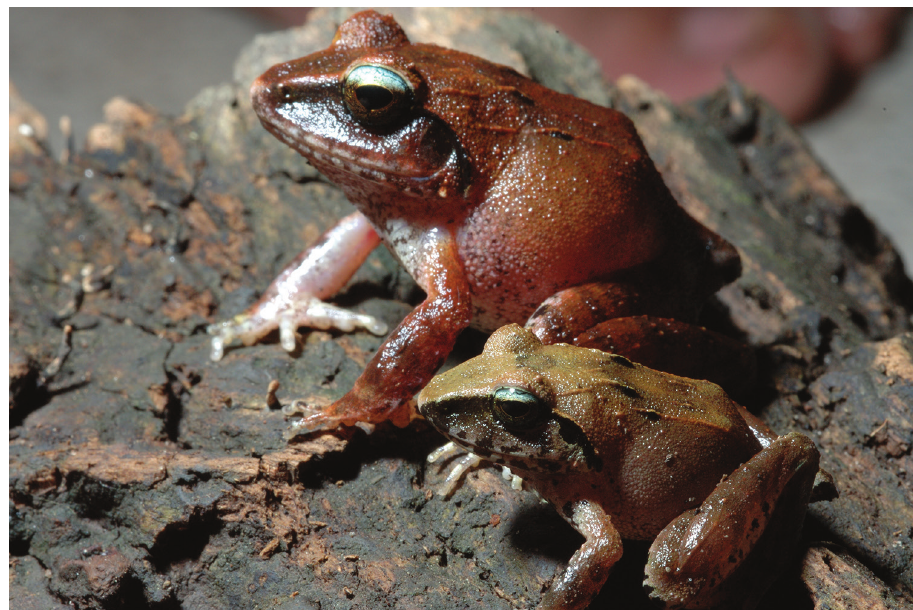
Figure 4. Platymantis cf. corrugatus male (KU 304501) and female (KU 304502) photographed together at Municipality of Mambajao, Mt. Mambajao, Camiguin Sur Island. Photo: